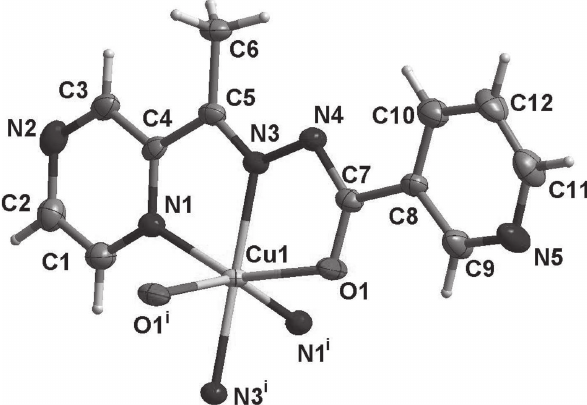
Table 2: Fractional atomic coordinates and isotropic or equivalent isotropic displacement parameters (Å 2